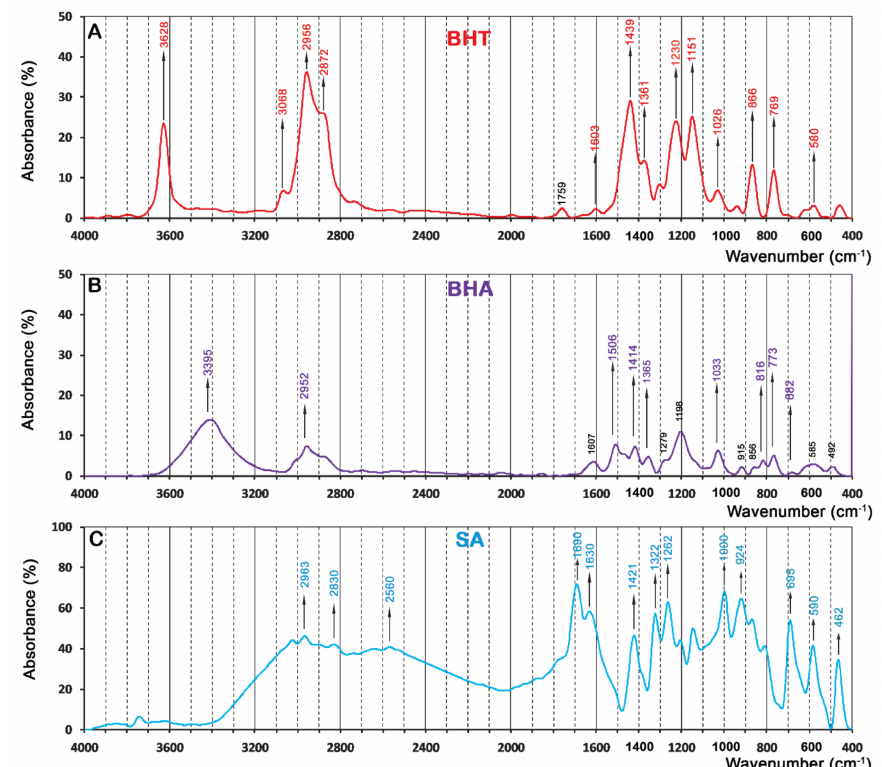
Figure 3. FTIR spectra of butylated hydroxytoluene, BHT ( A ); butylated hydroxyanisole, BHA, ( B ); and sorbic acid, SA ( C